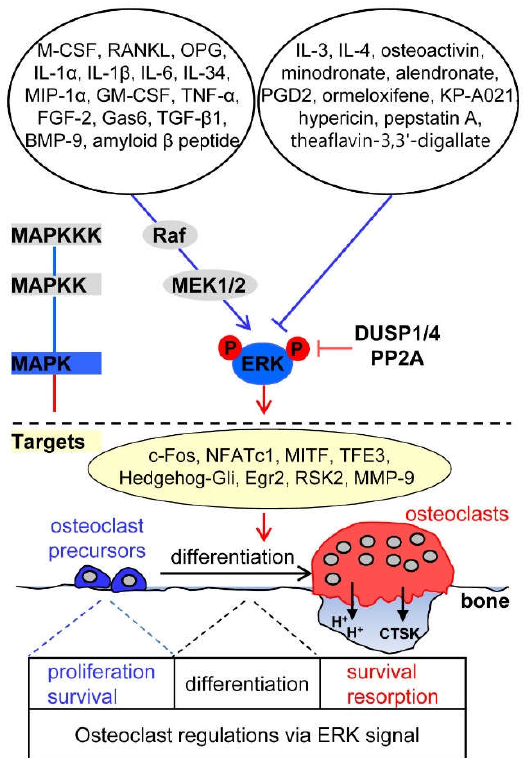
Figure 1. Osteoclastogenic signaling cascade controlled by upstream activators and inhibitors of extracellular signal-regulated kinase (ERK). The marked molecules are described in the text entitled “ERK signaling in osteoclasts”. CTSK, cathepsin K; M-CSF, macrophage colony-stimulating factor; RANKL, receptor activator of nuclear factor κ -B ligand; OPG, osteoprotegerin; IL, interleukin; MIP, macrophage inflammatory proteins; GM-CSF, granulocyte-macrophage colony-stimulating factor; TNF, tumor necrosis factor; FGF, fibroblast growth factor; TGF, transforming growth factor; BMP, bone morphogenetic protein; PGD2, prostaglandin D2; MAPK, mitogen-activated protein kinase; MAPKK, mitogen-activated protein kinase kinase; MAPKKK, mitogen-activated protein kinase kinase kinase; DUSP, dual-specificity phosphatase. Arrows indicate activation of the signaling pathways while T bars indicate inhibition of the signaling pathways.